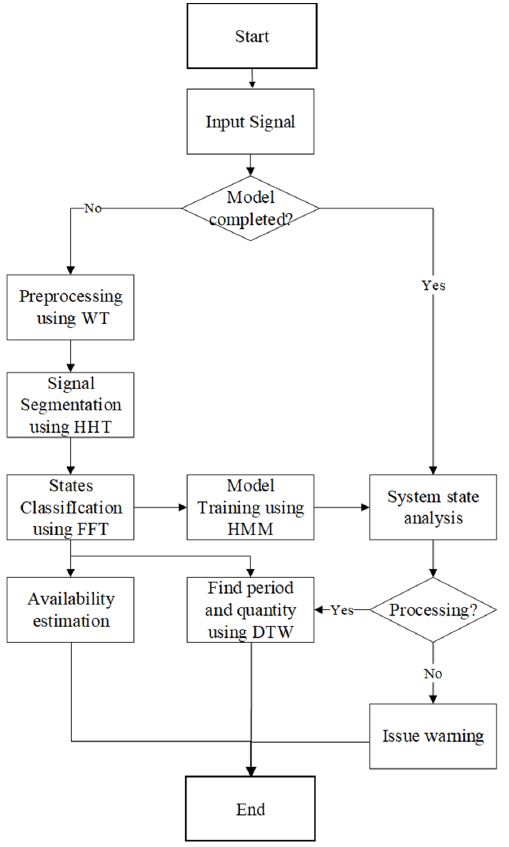
Figure 2. Flowchart of the proposed framework.